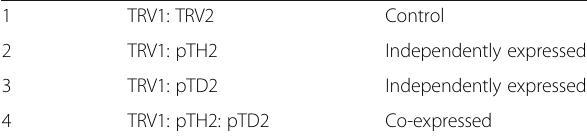
Table 1 Sets of infiltrations